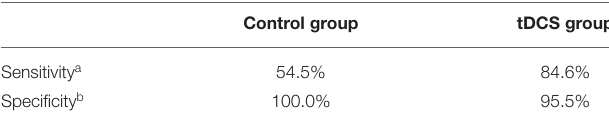
TABLE 5 | Sensitivity and specificity of evaluating the prognostic evaluation in of